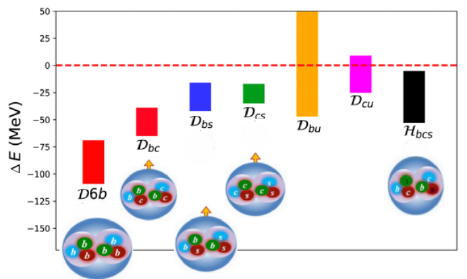
Figure 13. Binding energies of dibaryons with heavy quarks according to the lattice simulations [63–